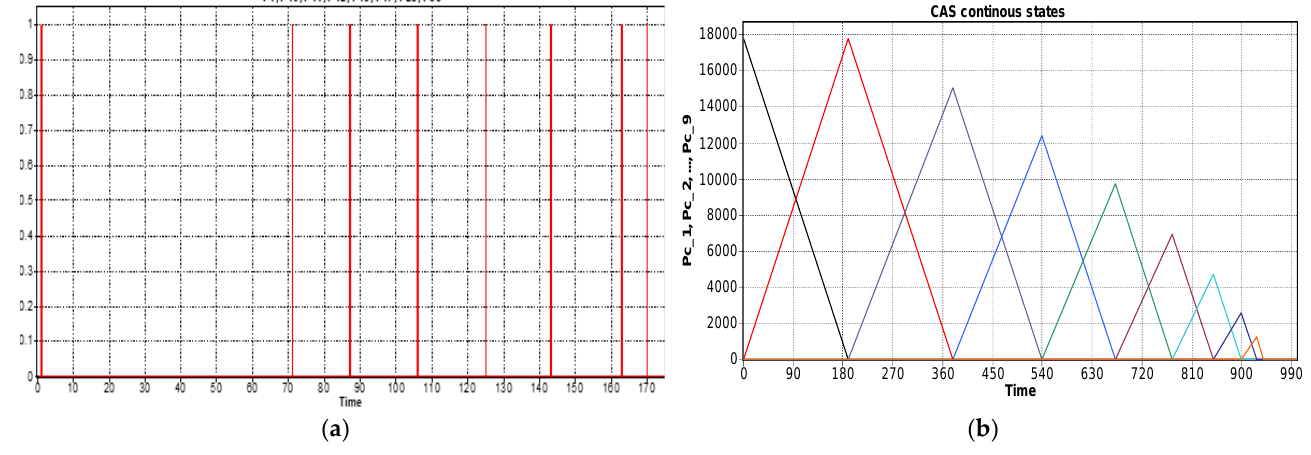
Figure 12. ( a ) The monitoring signals for the successive actions of the WP2 disassembly. ( b ) The continuous places evolution of the CAS (PeopleBot WMR) places: P c_1 ,..,P c_9